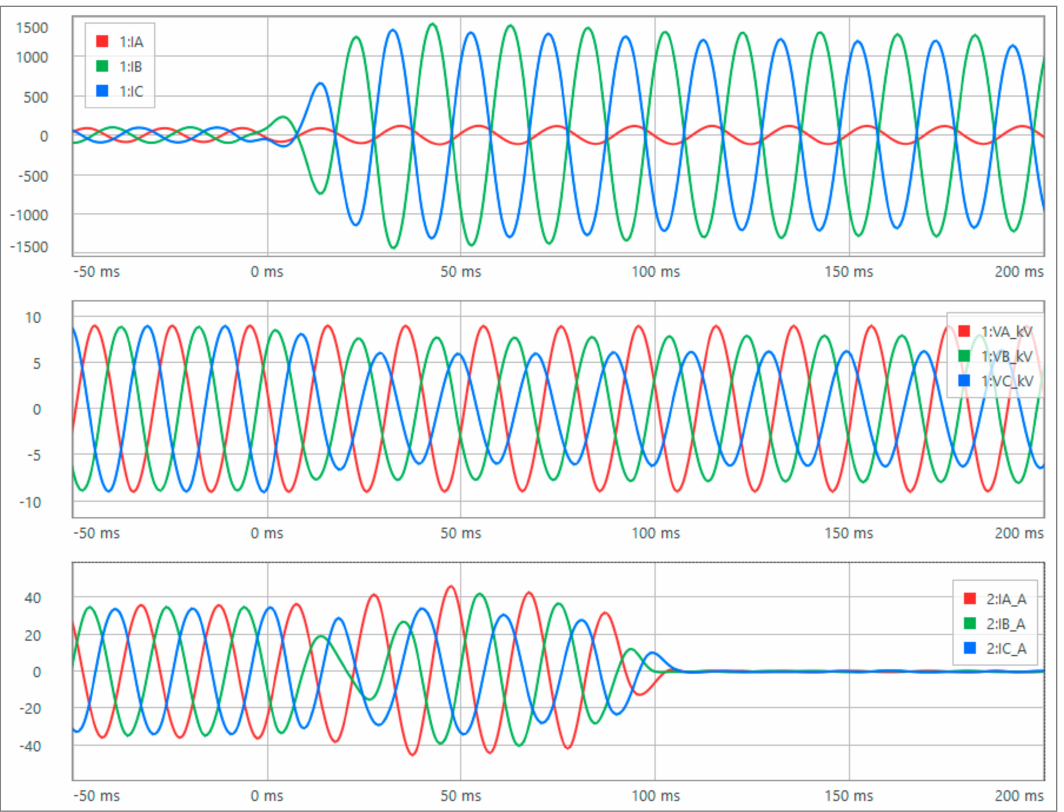
Figure 6. F2 line-to-line fault event traces: CB2 relay currents ( top chart) in A, CB2 relay 11 kV line-to-ground voltages ( middle chart) in kV, and CB21 relay currents ( bottom chart) in